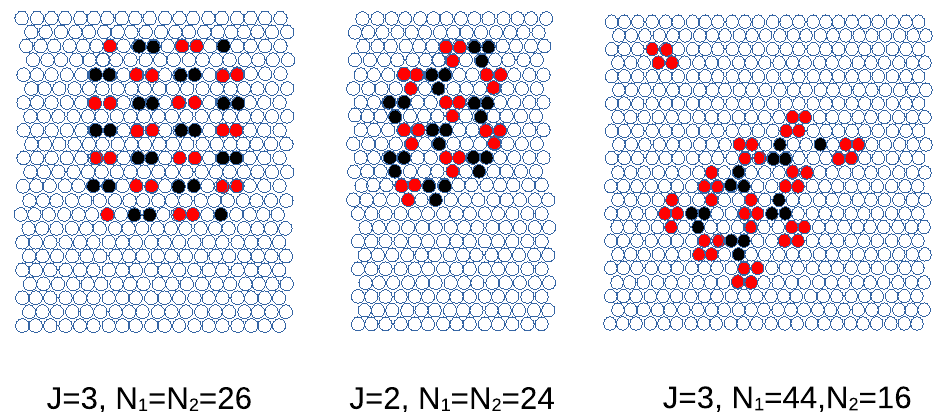
Figure 4. Representative patterns self-assembled for a fixed number of particles and T ∗ → 0, inferred from canonical MC simulations at T ∗ = 0.2. The numbers of particles and the ratio of the interactions between the third and the first neighbors are indicated in the figure. Empty and filled circles represent empty and occupied cells of the triangular lattice, with red and black colors referring to the first and the second component